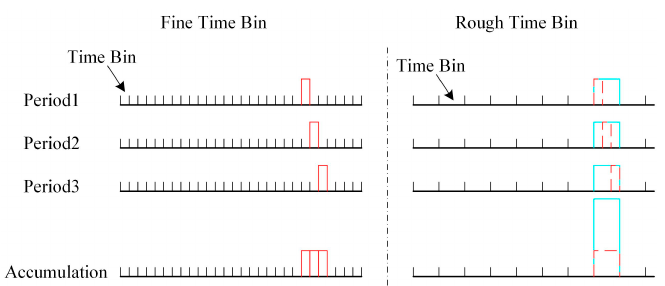
Figure 3. The e ff ect of target motion on pulse accumulation in the case of fine time bin and rough Figure 3. The effect of target motion on pulse accumulation in the case of fine time bin and time rough time bin.